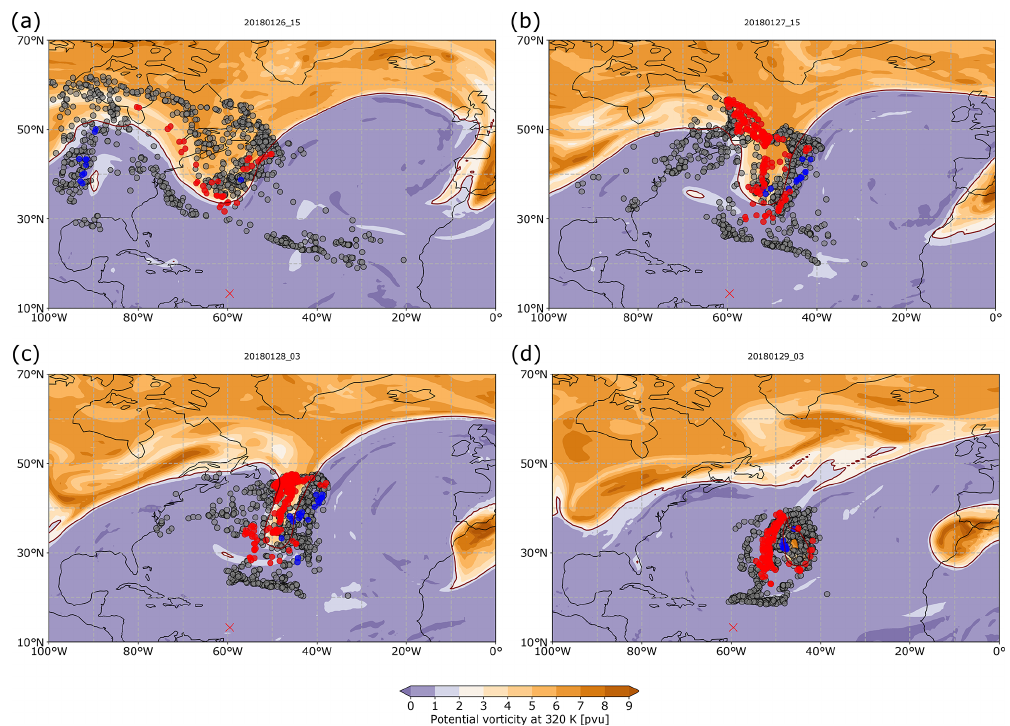
Figure 13. The same as Fig. 12 but from 26–29 January 2018 and with air parcels that reach Barbados between 1–4 February. The air parcels that experience rapid ascent ( < − 300hPa(2d) − 1 ) or descent ( > 300hPa(2d) − 1 ) centred at the time shown in the figure are highlighted in blue and red, respectively. An animation illustrating the 3-hourly evolution of the large-scale flow fields in the period 26 January to 4 February 2018 is provided as Supplement